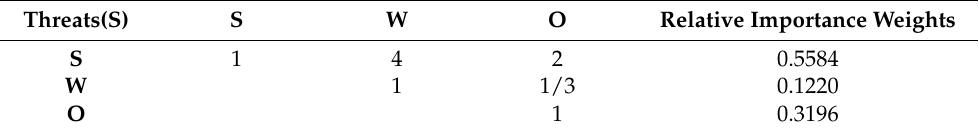
Table A7. The interdependence matrix of the SWOT factors with respect to